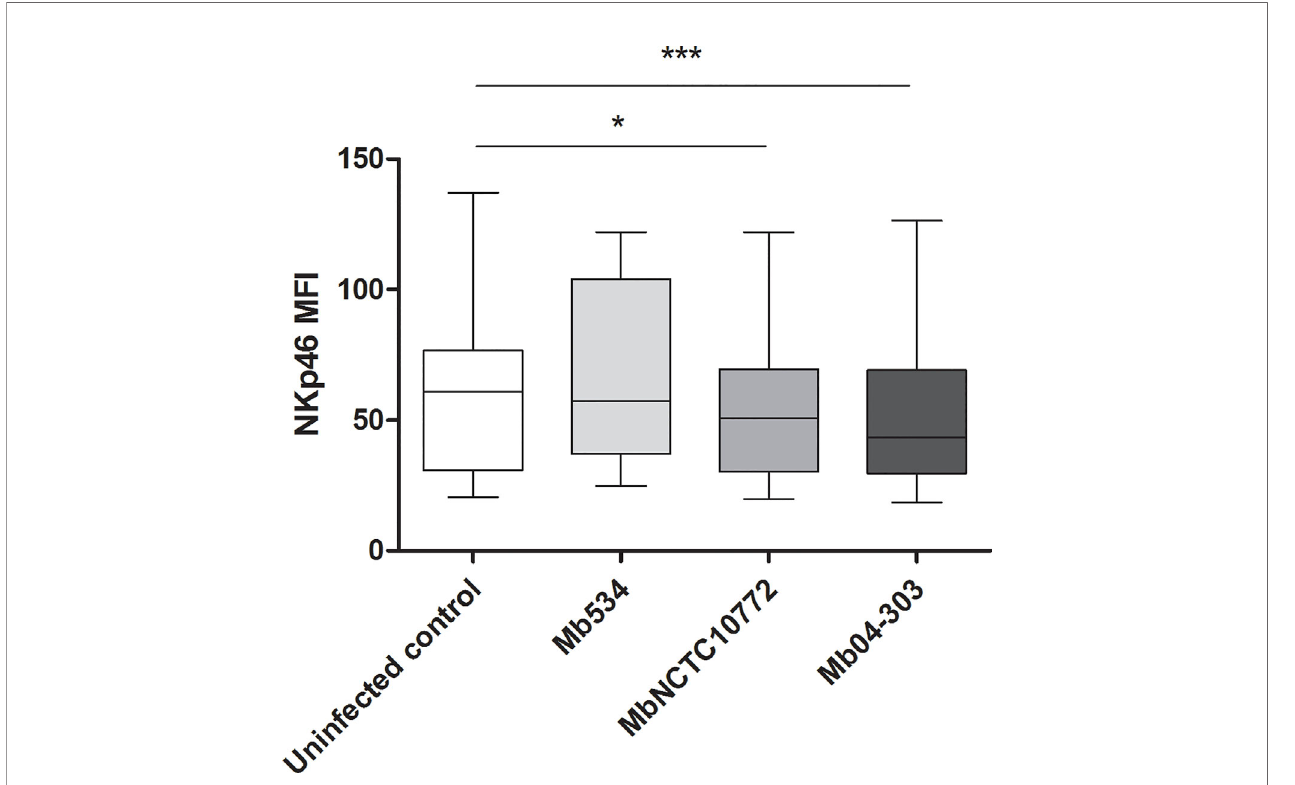
FIGURE 5 | Mean fl uorescence intensity (MFI) of NKp46 expression in NK cells. For each animal sample and condition tested a single cell well was analyzed. Whiskers and plots indicate minimum, maximum and mean values (*signi fi cant differences; p < 0.05 and ***p < 0.001 by Friedman